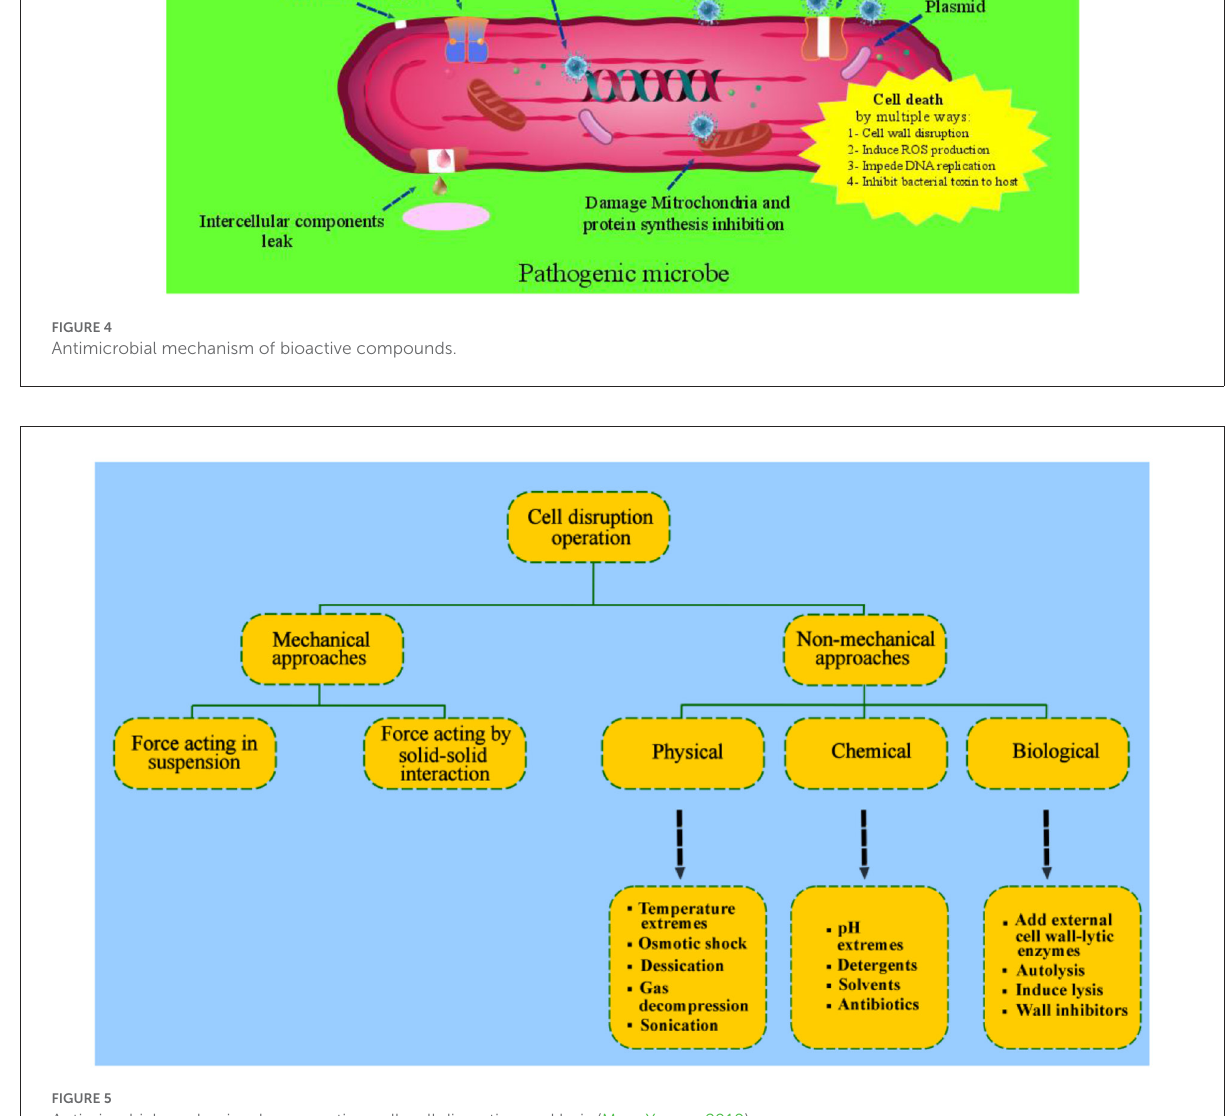
aggregate the multicellular composites; thus, inhibiting bacteria growth. Flavonoids such as; (1) galangin, (2) isovitexin, (3) 3- O-octanoyl-epicatechin, and (4) 5, 7, and 40-trihydroxyflavanol